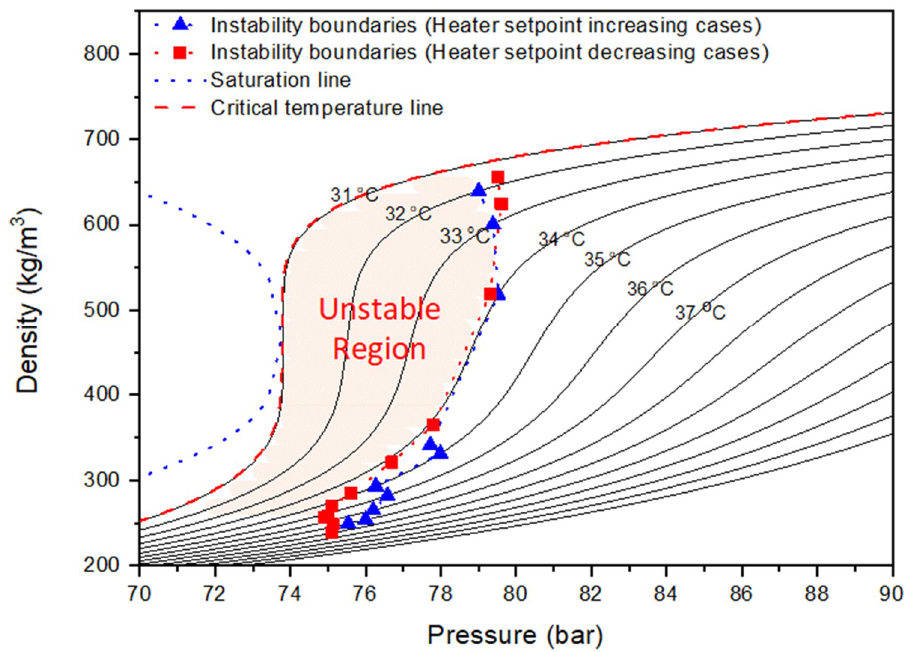
Figure 9. Pressure–density diagram of CO 2 with an unstable region.